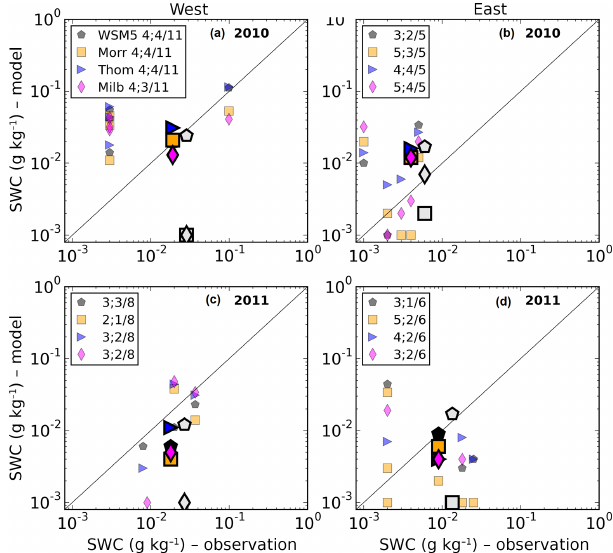
Figure 9. Scatter plot of simulated solid-water content (SWC; ice, snow, graupel) versus observed SWC in 2010 (a, b) and in 2011 (c, d) on the western side of the peninsula (a, c) and on the eastern side of the peninsula (b, d) . The small light-coloured mark- ers show the average per flight, while large coloured bold markers give the average over the whole tracks on each side of the peninsula. The large light grey markers show the simulated ice water content (IWC) averages corresponding to each simulated SWC average (for readability each light-grey marker is slightly shifted on the x axis by 50% of the measured value). The numbers next to each scheme’s name ( n 5 ; n 5 0 /N ) give the number n 5 ( n 50 ) of simulated flights with a SWC of at least 5% (50%) of the observed SWC to the total number N of flights measuring an average ice content of at least 0.0001gkg − 1